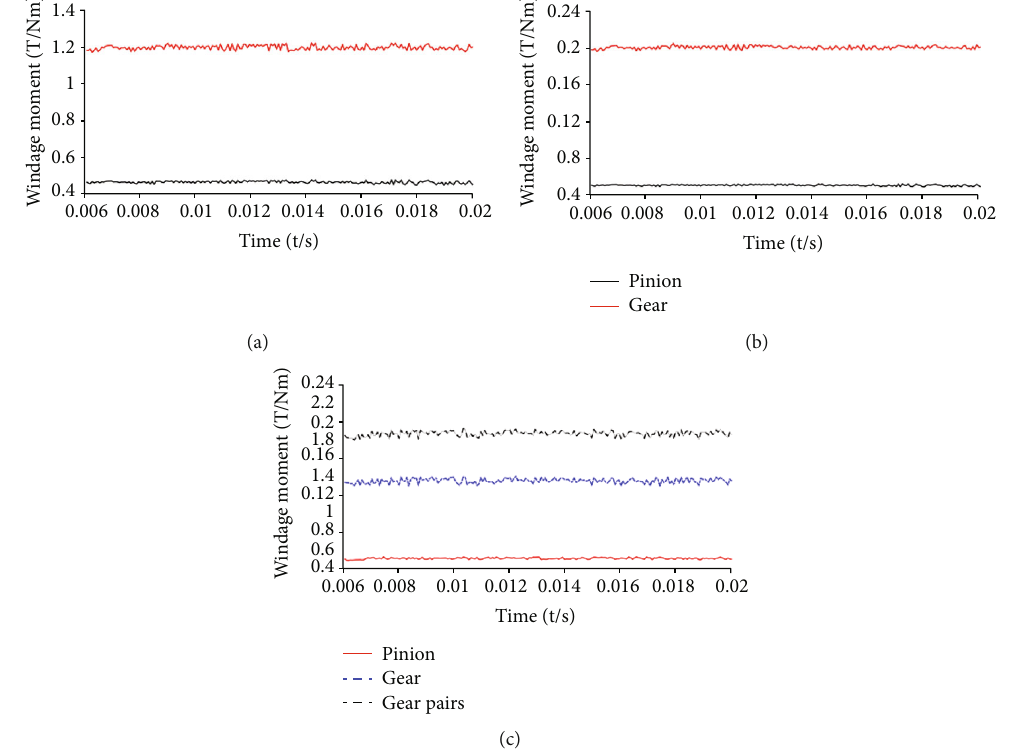
Figure 7: Windage moment curves of gear pair with time (a) tooth surface, (b) end surface, and (c) the gear pairs.